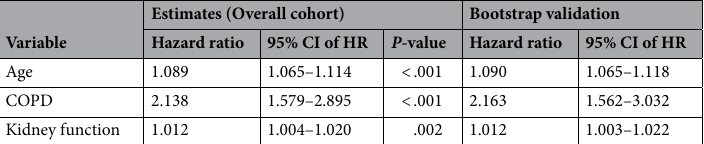
Table 2. Updated model predicting overall